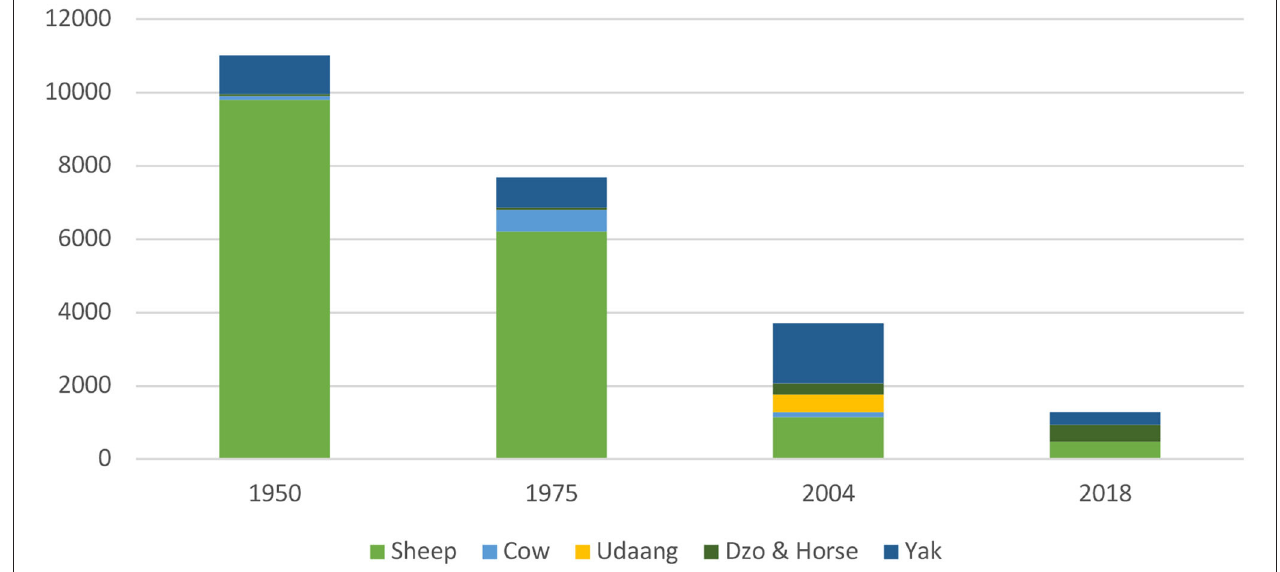
FIGURE 2 | Livestock numbers and composition change in KNP between the year 1950–2018, Source: (1950–2004, Tambe and Rawat, 2009b), 2018: Author’s